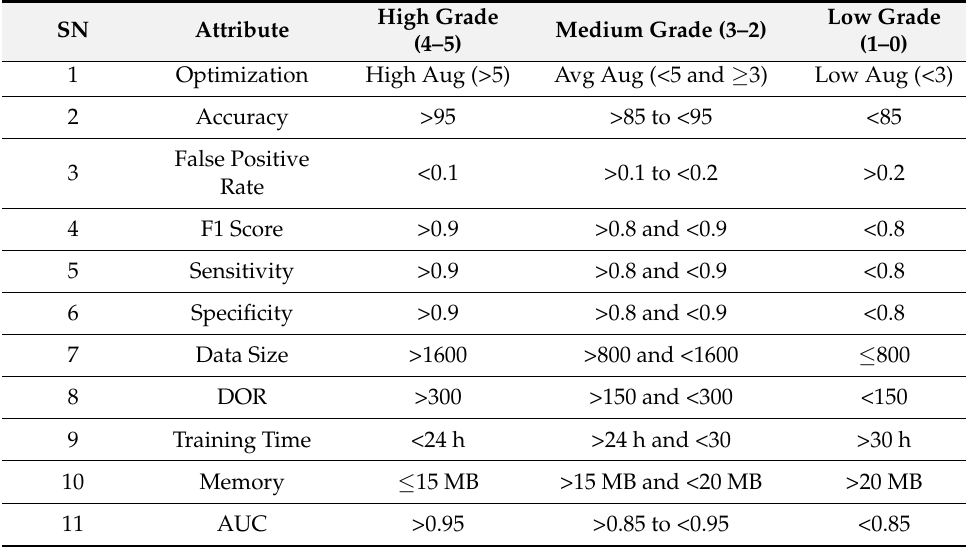
Table A2. Grading scheme for the attributes of AI